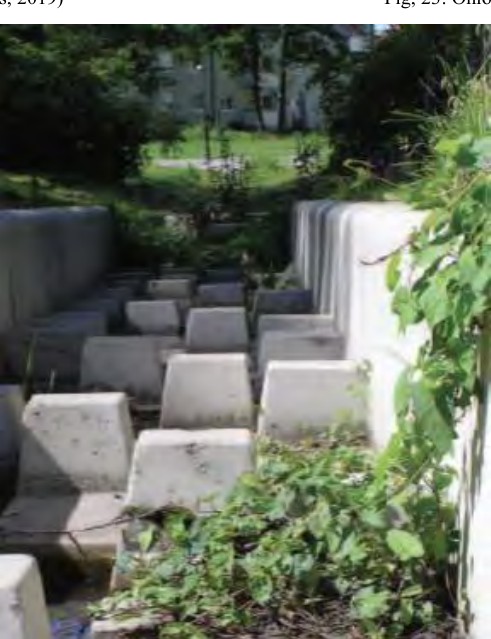
Fig. 22: Bioswales. (Klamméus, 2019) Fig, 23: Onion gutter. (Klamméus, 2019)